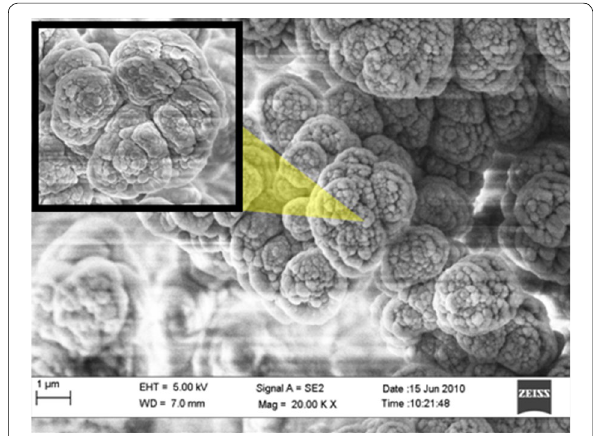
Fig. 4 The poly(methyl acrylate) monolith column in the microfludic channel a , b without and c , d with the grafting layer. (b) and (d) shows the interface between the monolith and the surface of the microfluidic